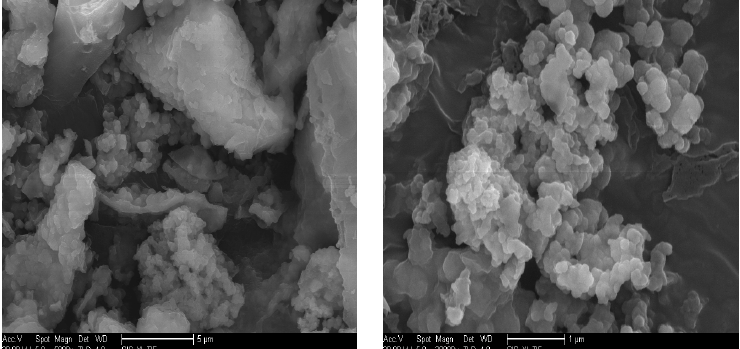
Figure 6. Scanning electron micrographs of Se-CSPS and